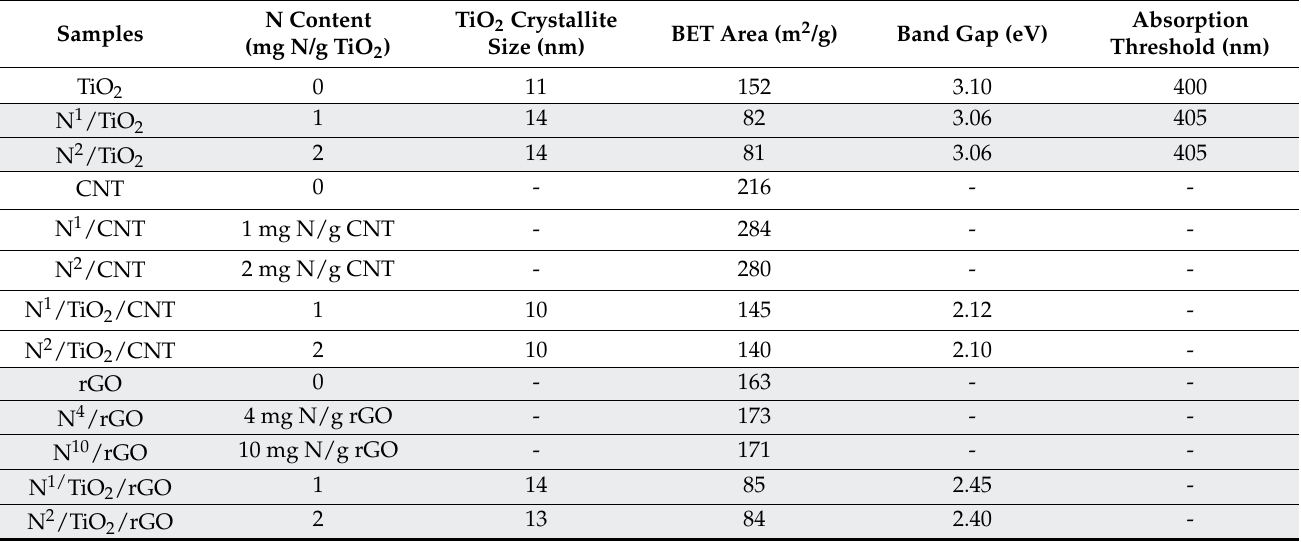
The gray background represents the same type of